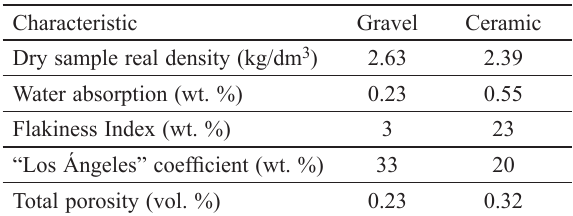
Table 1. Physical and mechanical properties of coarse aggregates Characteristic Gravel